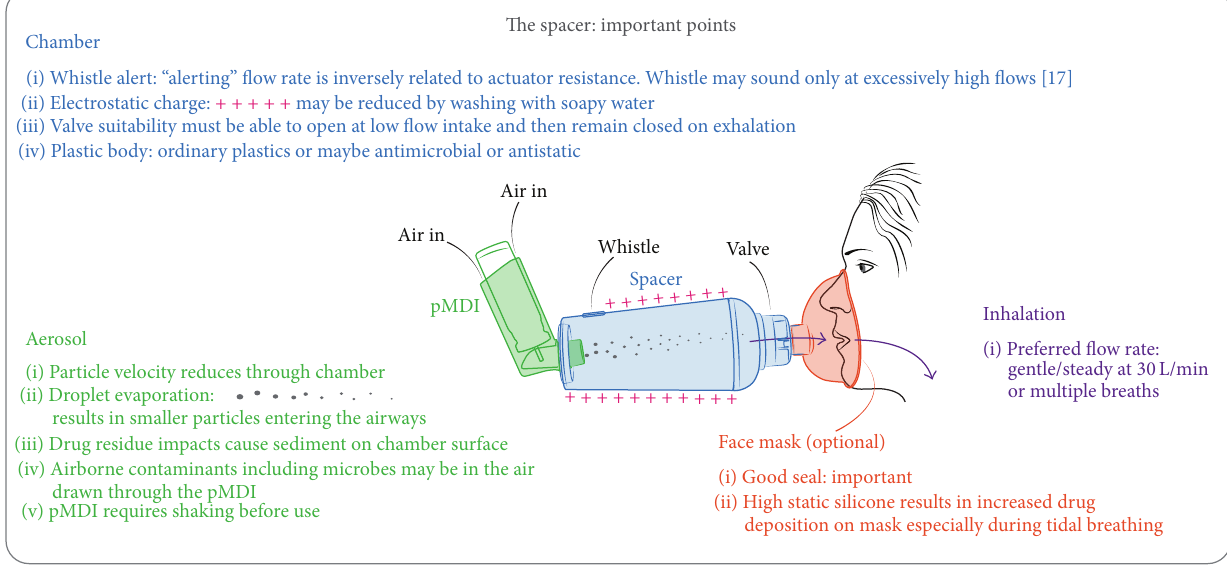
Figure 2: Spacer features, drug formulation, and in-use technique can affect pMDI drug